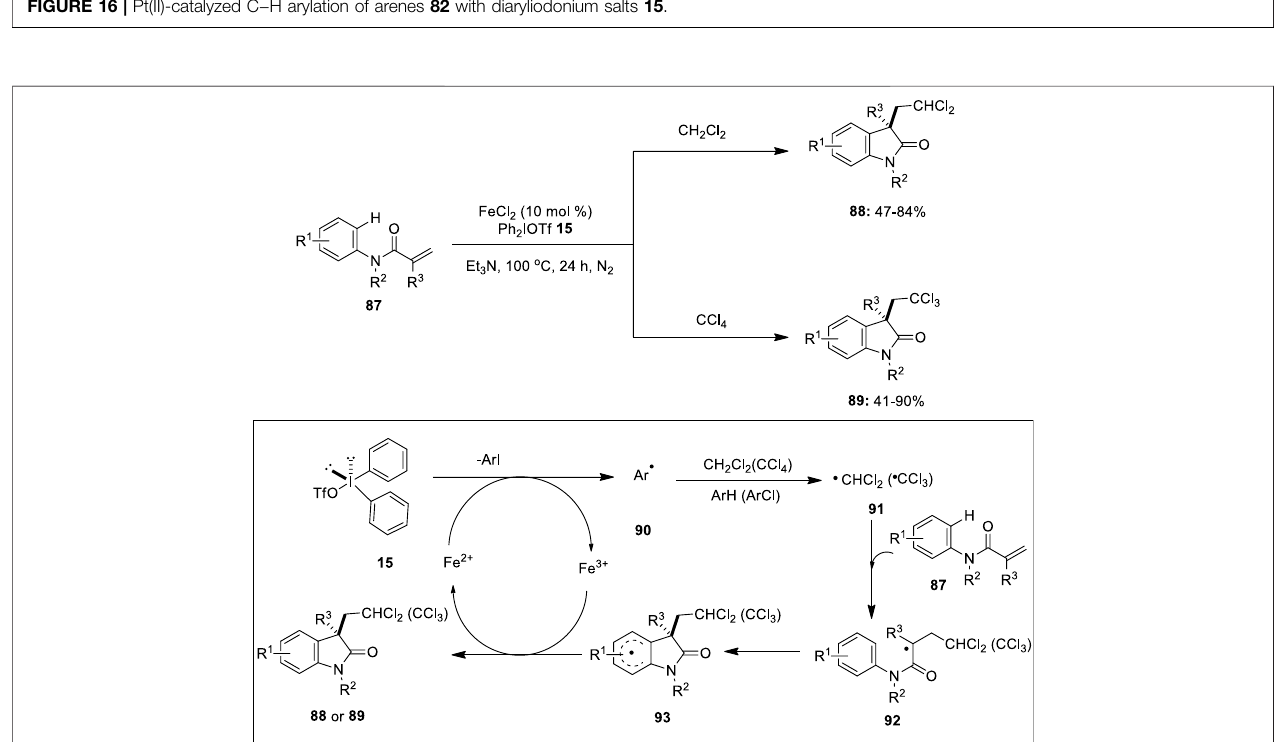
FIGURE 17 | Iron(II)-catalyzed carbodi- and trichloromethylation/cyclization of N -arylacrylamides 87 using diaryliodonium salt 15 as an oxidant.